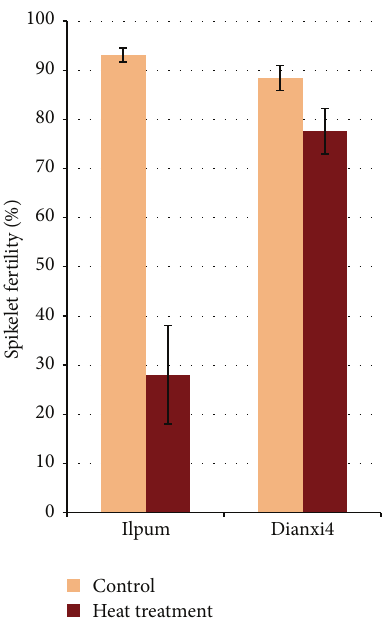
Figure 1: Comparison of spikelet fertility of Ilpum and Dianxi4 at (orange) normal condition and (brown) heat